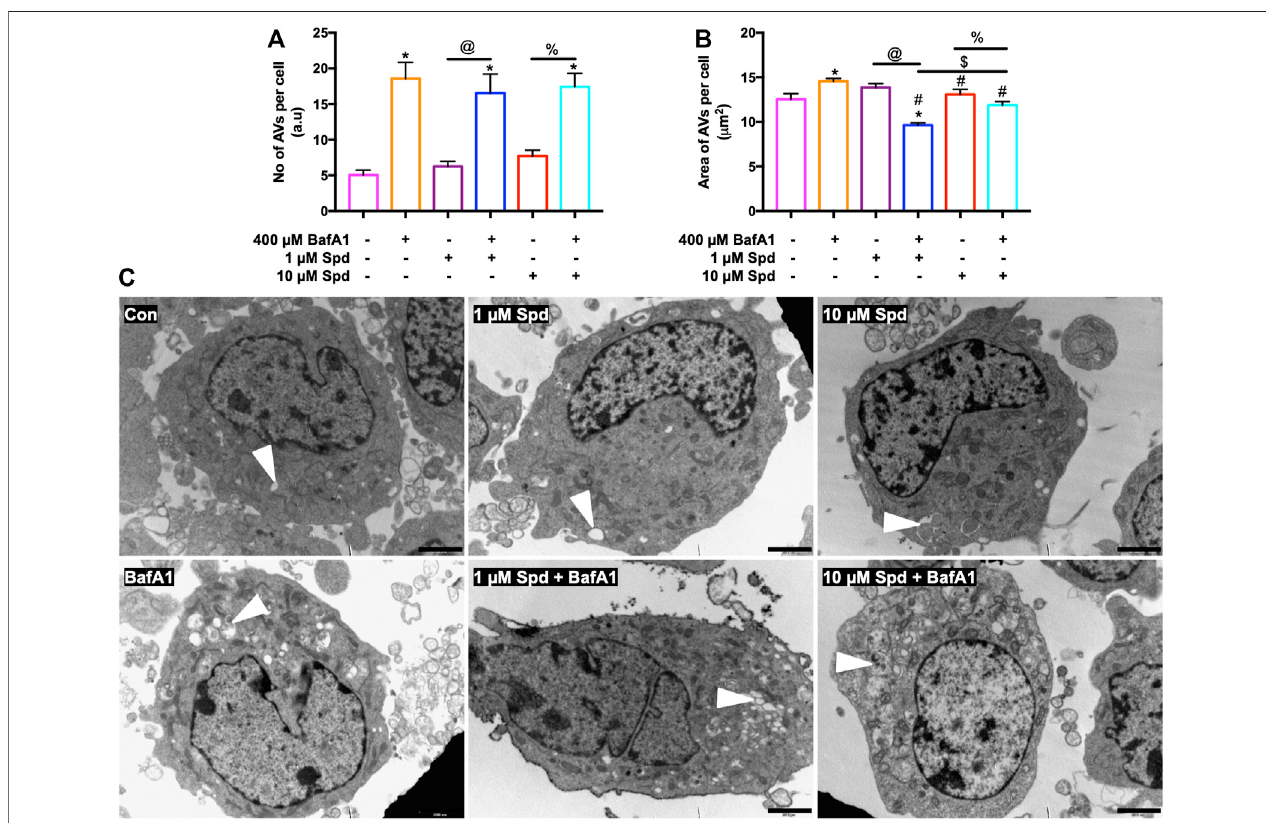
FIGURE3| SpermidineaffectsthesizeofAVsinaconcentration-dependentmannerbuthasnoeffect onthenumberofAVs. (A,B) morphometricanalysisand (C) representativeTEMmicrographsofautophagicvacuoles(AVs)inGT1-7cellsfollowingtreatmentwith1and10 μ Mspermidineinthepresenceandabsenceofsaturating concentrations ba fi lomycin. Data are presented as mean ± SEM, n = 2 with a total of 30 images analysed per treatment group. * = p < 0.05 vs control, # = p < 0.05 vs. BafA1, $ = p < 0.05 vs. 1 μ M Spd + BafA1, @ = p < 0.05 vs. 1 μ M Spd and % = p < 0.05 vs. 10 μ M Spd, arbitrary units (a.u). Arrowheads indicate AVs. Scale bar: 2000